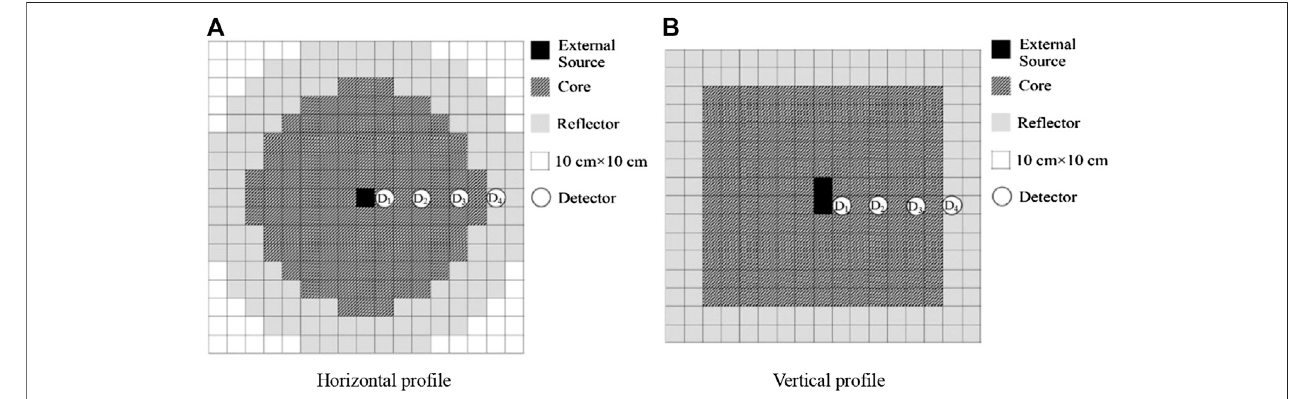
FIGURE 1 | Schematic of ADSR.